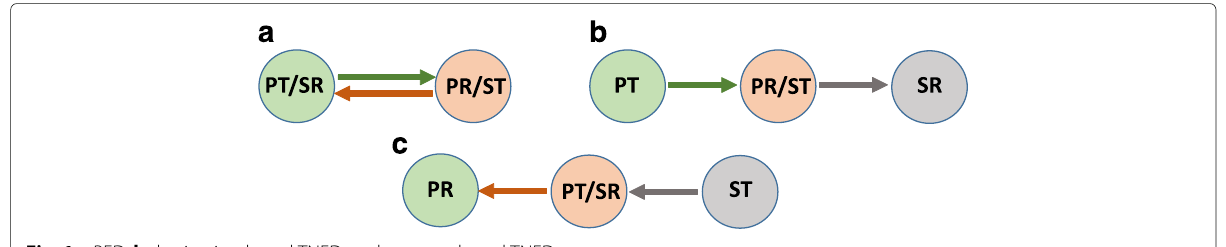
Fig. 1 a BFD, b destination-based TNFD, and c source-based